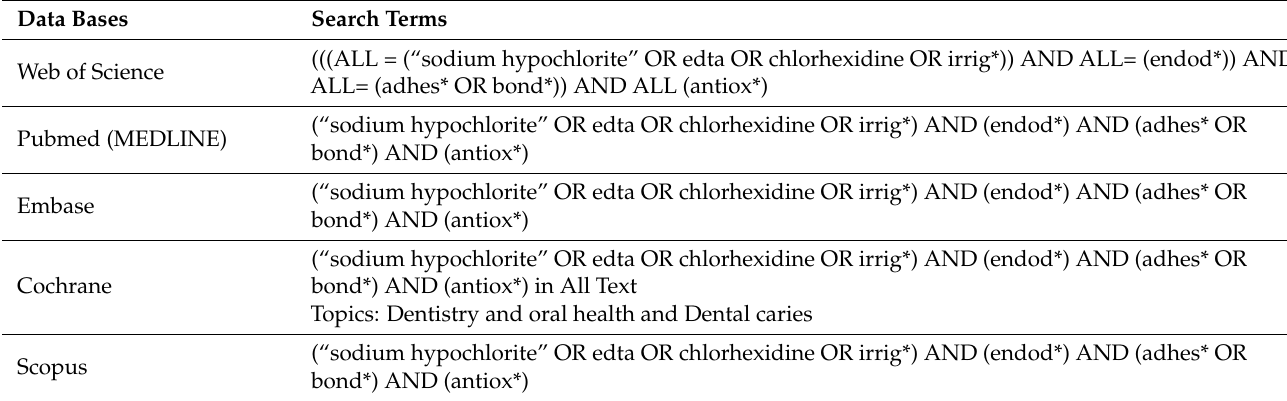
Table 1. Search terms used in